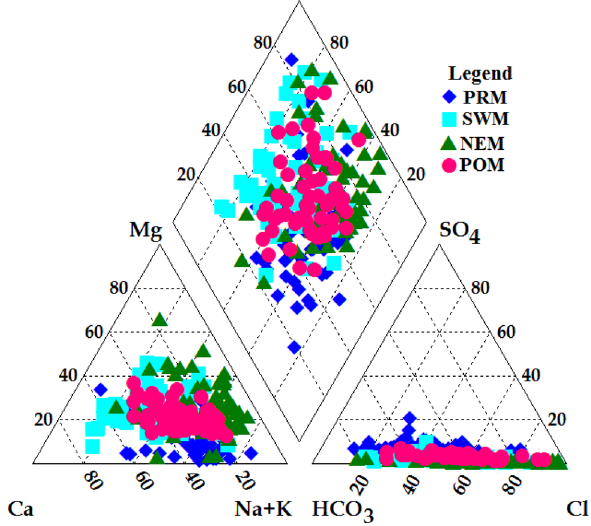
Fig. 4 Piper plot exhibiting the chemical facies of groundwater sam- ples for different